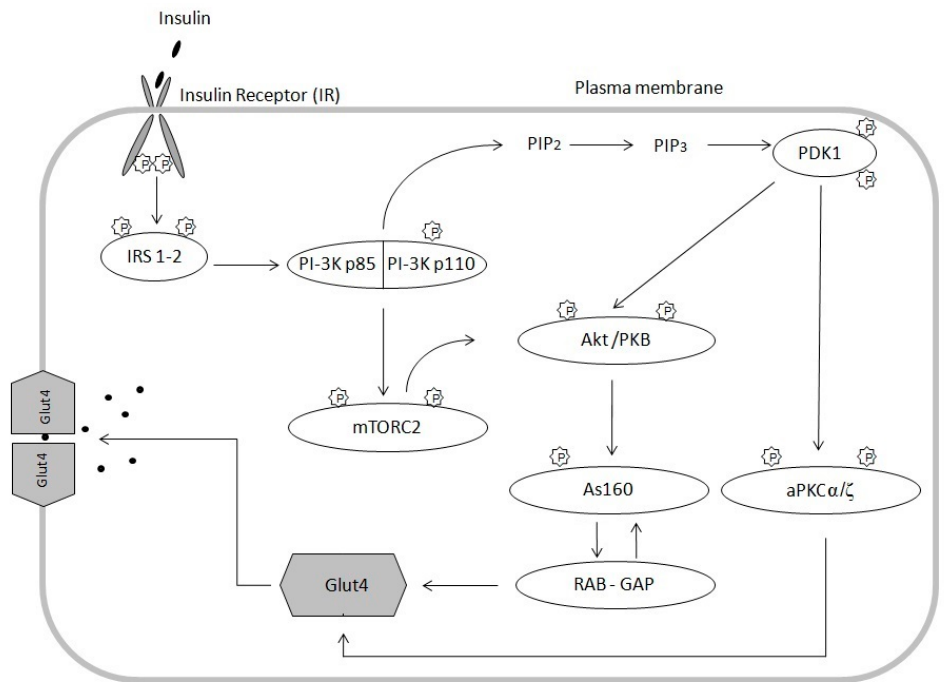
Figure 1. Insulin signaling pathway; Insulin stimulates the insulin receptor (IR), leading to phosphorylation of insulin receptor substrate (IRS). Recruitment of phosphatidylinositol 3-kinase (PI3K), generated of the second messenger PIP3, leading to the recruitment of Akt and subsequent phosphorylation by the upstream mediators PDK1 and mTORC2. PDK1 phosphorylates and activates PKC- ζ and α isoforms. Activated Akt phosphorylates Akt substrate 160 (AS160), thereby inactivating its Rab-GAP domain and preventing the hydrolysis of GTP to GDP by Rab proteins. This results in processes promoting the translocation of GLUT4 to the cell surface.